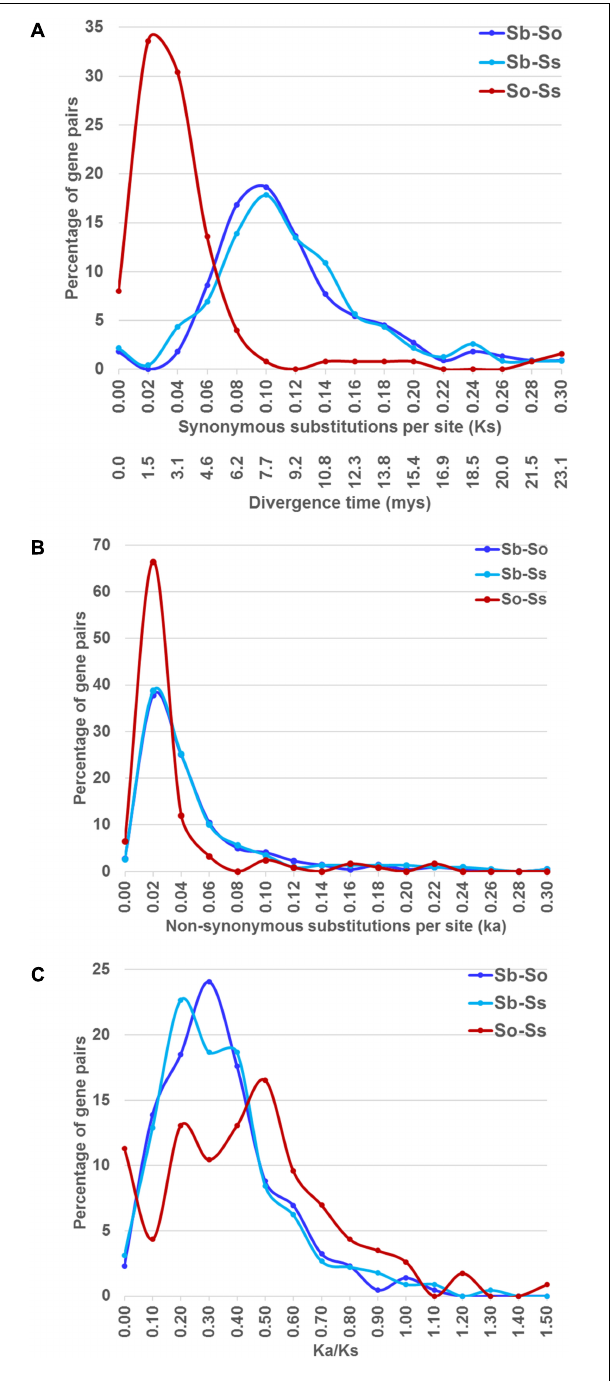
FIGURE 4 | The frequency distribution of the Ks and the corresponding divergence times (A) , Ka (B) , and Ka / Ks values (C) between sorghum and Saccharum , and between S. officinarum and S. spontaneum